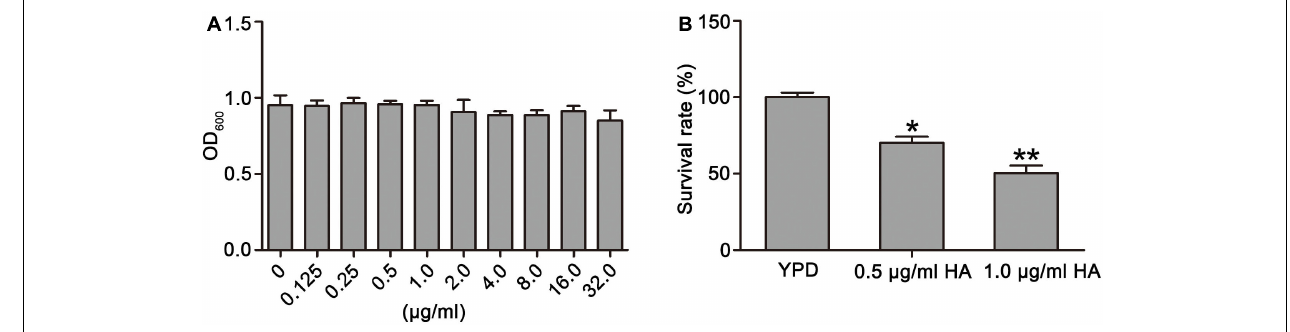
FIGURE 1 | Effects of HA on growth and survival of C. albicans were observed. (A) The OD 600 value was measured after treatment by different concentrations of HA without illumination for 24 h. (B) Survival rate was determined after HA treatment with illumination for 30 min by counting colony-forming units (CFUs). Data were shown as mean ± SD ( n = 5). ∗ P < 0.05 and ∗∗ P <